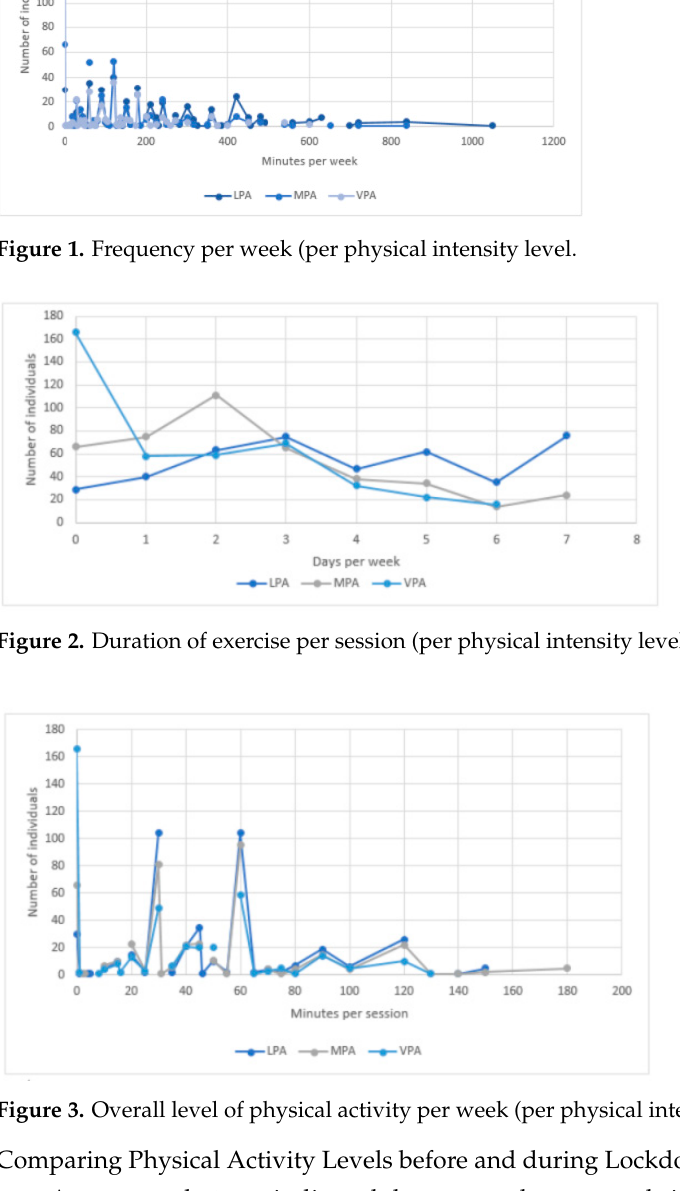
Figure 3. Overall level of physical activity per week (per physical intensity level).